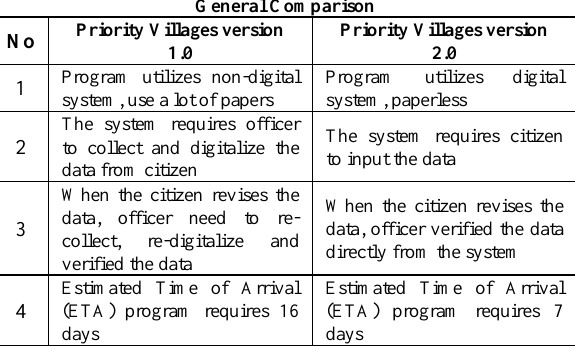
Table 2 . General program